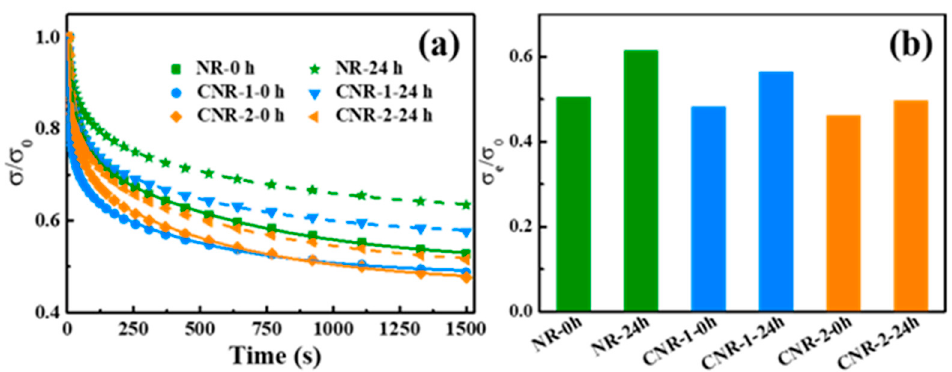
Figure 7. Stress relaxation curves ( a ) and residual stress ( b ) of NR, CNR-1, and CNR-2 before and after accelerated storage.